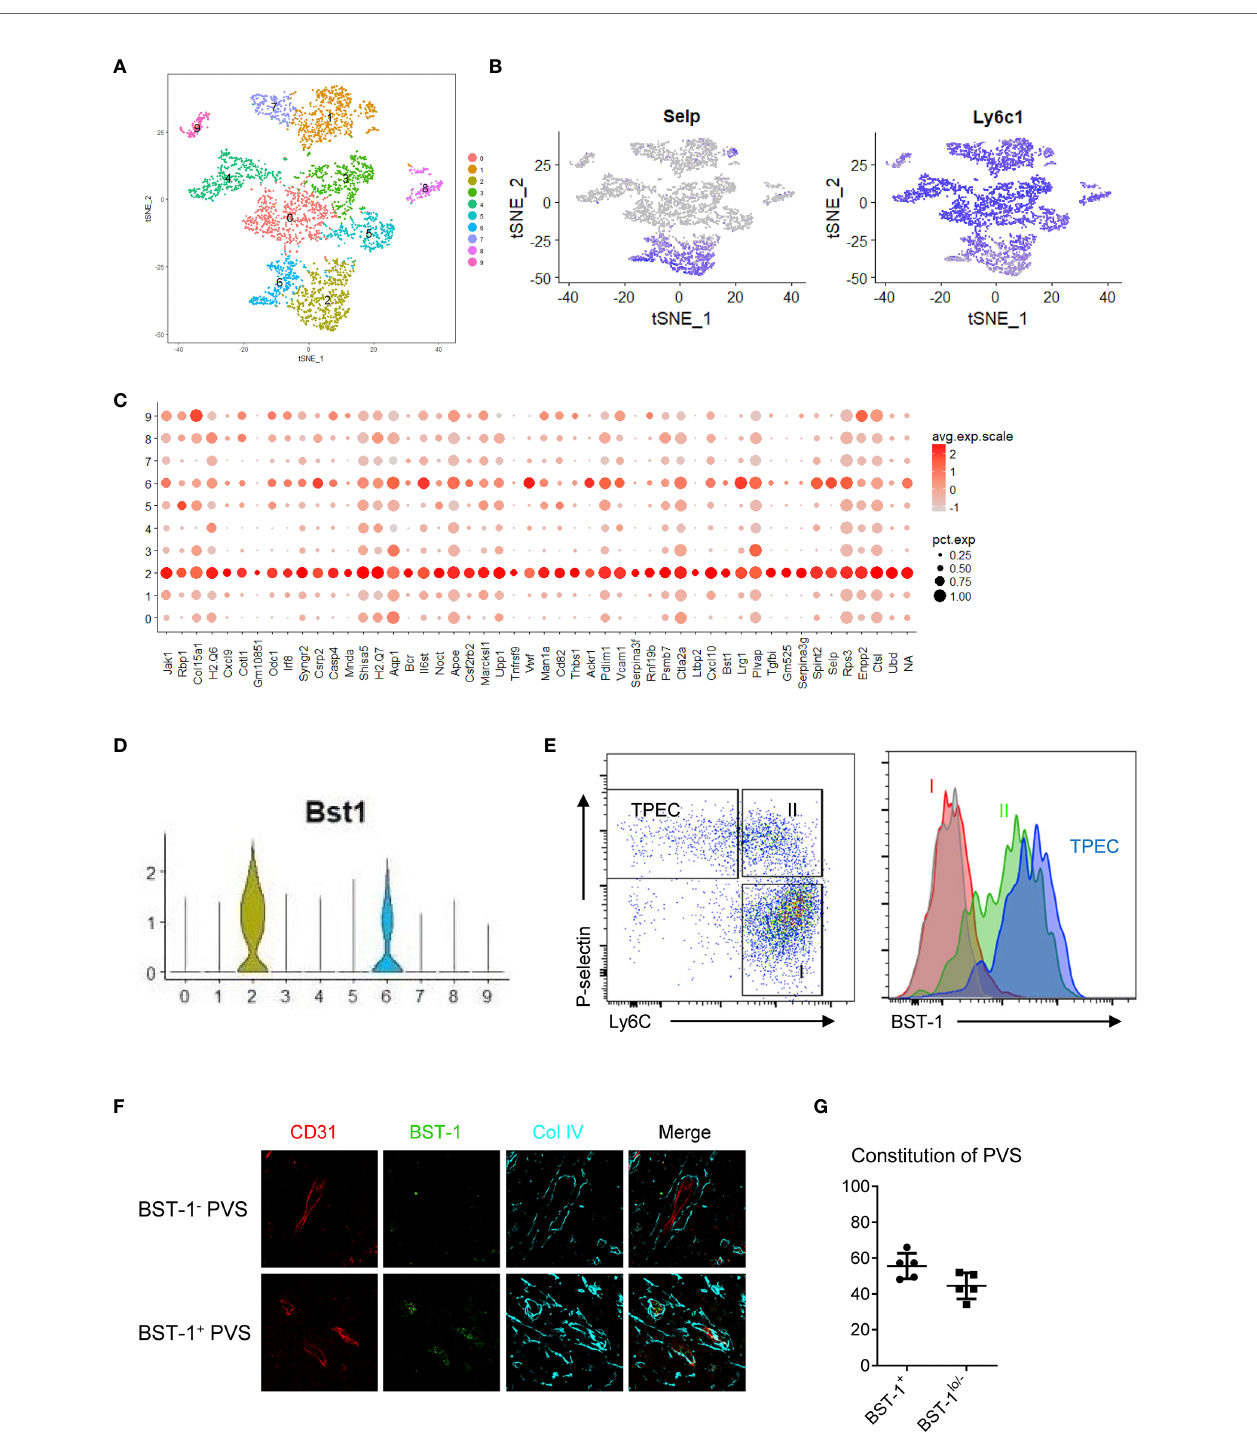
FIGURE 6 | TPECs are heterogeneous and can be divided into two subsets via BST-1 expression level. (A) t-SNE analysis of scRNA-seq data from total thymic ECs readily divide thymic ECs into 10 clusters. (B) Transcriptional level of P-selectin (left) and Ly6C (right) in the thymic ECs. (C) Signature genes of cluster 2 (C2). (D) Violin plot analysis of BST-1 gene expression on different clusters of thymic ECs. (E) Flow cytometric analysis of BST-1 protein expression on major subsets of thymic ECs. Left: gating strategy. Subset I: Ly6C + P-selectin − ; Subset II: Ly6C + P-selectin + ; TPEC: Ly6C - P-selectin − . Right: histogram of BST-1 expression. Gray: isotype control; Red: Subset I; Green: Subset II; Purple: TPEC. (F) BST-1 expression on vessels within PVS. Representative photos of PVS surrounding vessels with different expression levels of BST-1 are shown. (G) Statistical analysis of BST-1 + and BST-1 lo/ − PVS surrounding